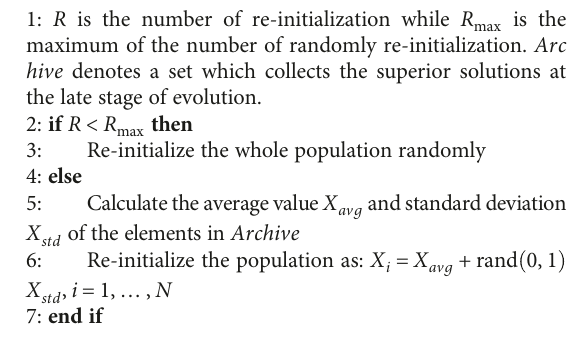
Algorithm 3: Mix